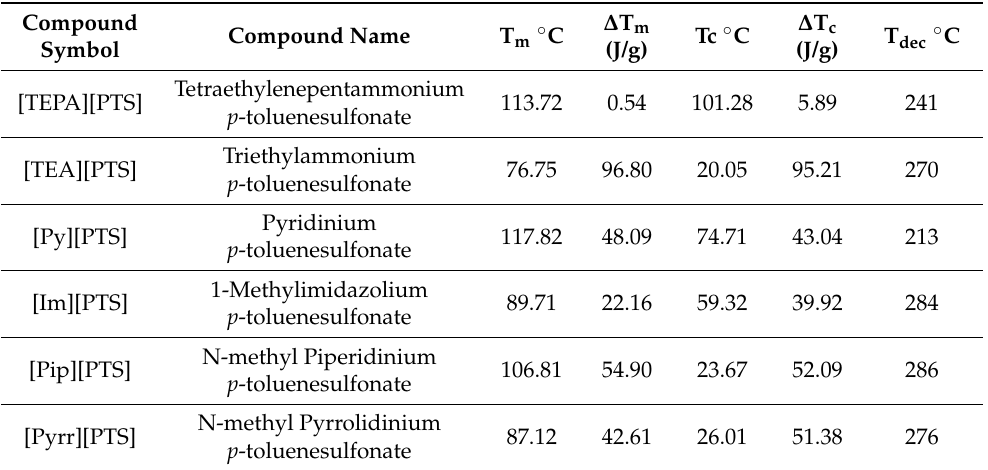
Table 2. Important thermal properties of the p -toluene sulfonic acid [PTS] anion based protic ionic liquids